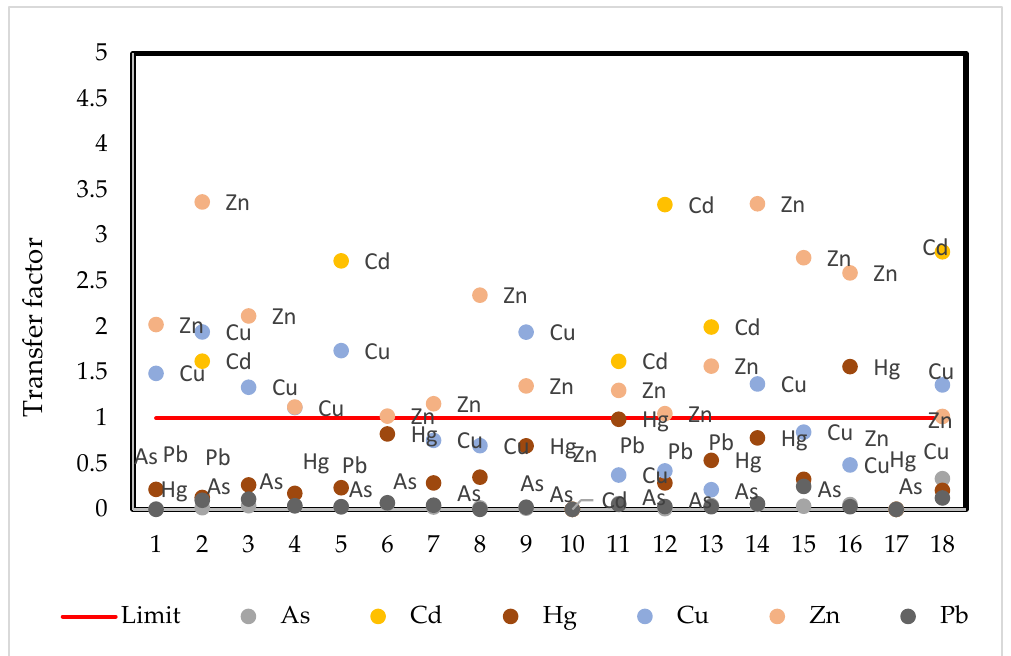
Figure 4. Transfer factor for cocoa beans-soil. The red line represents the limit above which metals are observed to be able to be transferred in the plant.